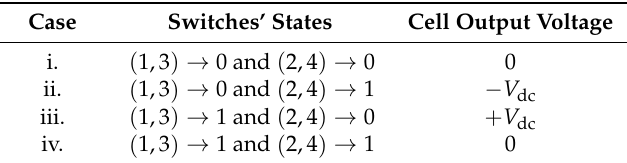
Table 1. Switching angles in different